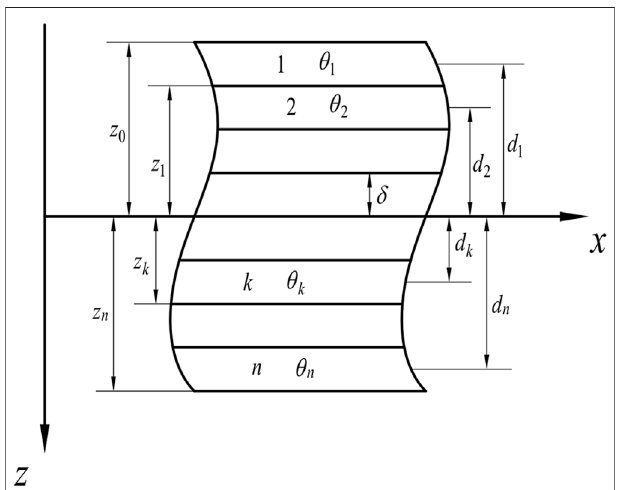
denotes the orientation of ply k , and each ply is of constant thickness, δ . z k − 1 , d k , and z k are the transverse coordinates of the top, middle, and bottom surface of the k th ply,